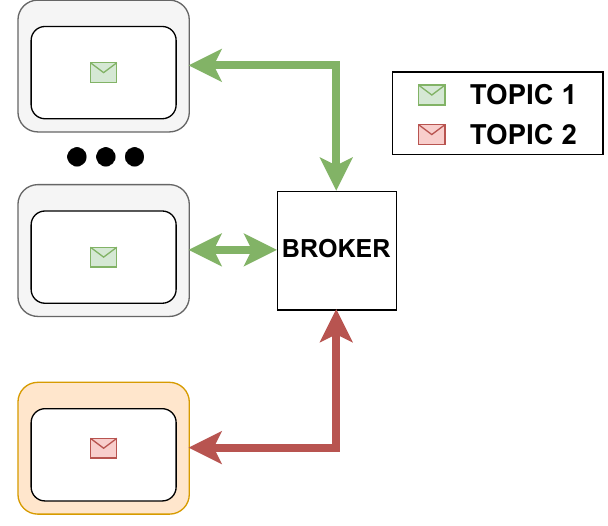
Figure 3. MQTT-SN baseline